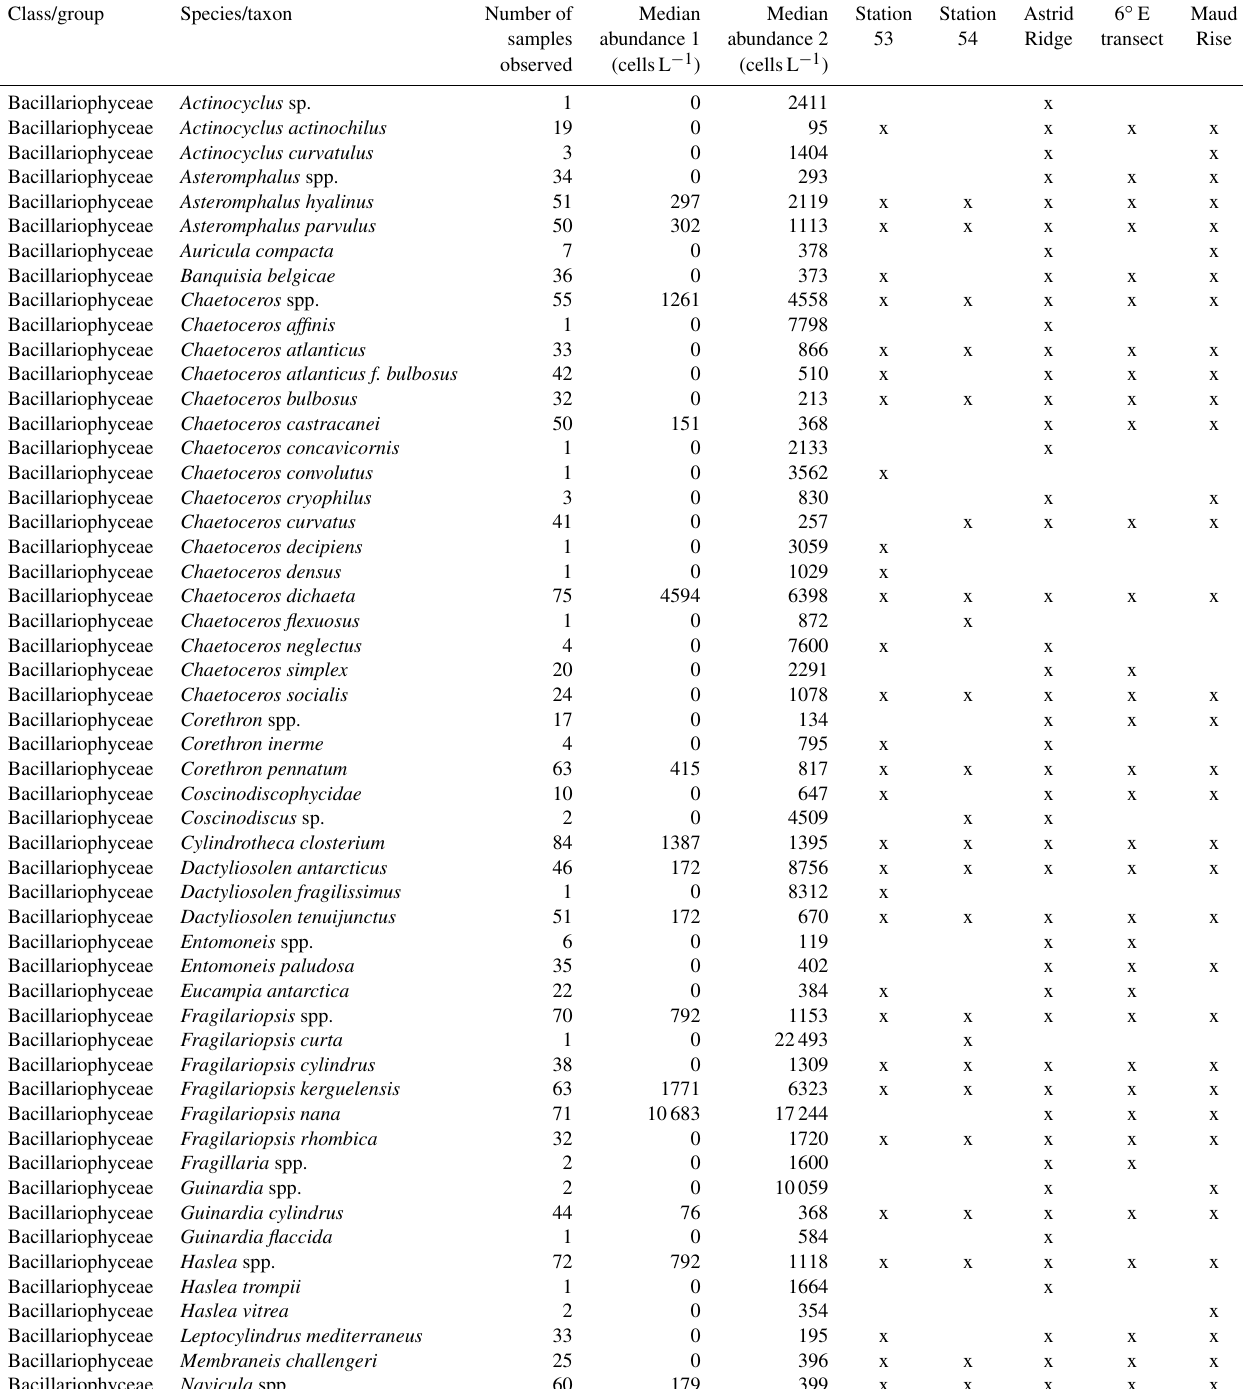
Table B1. All taxa identified in the CTD station samples down to 100m (in total 87 samples). For median abundance 2, only the samples where the species/taxon was observed were taken into account (i.e., zero abundances do not contribute to the median value).